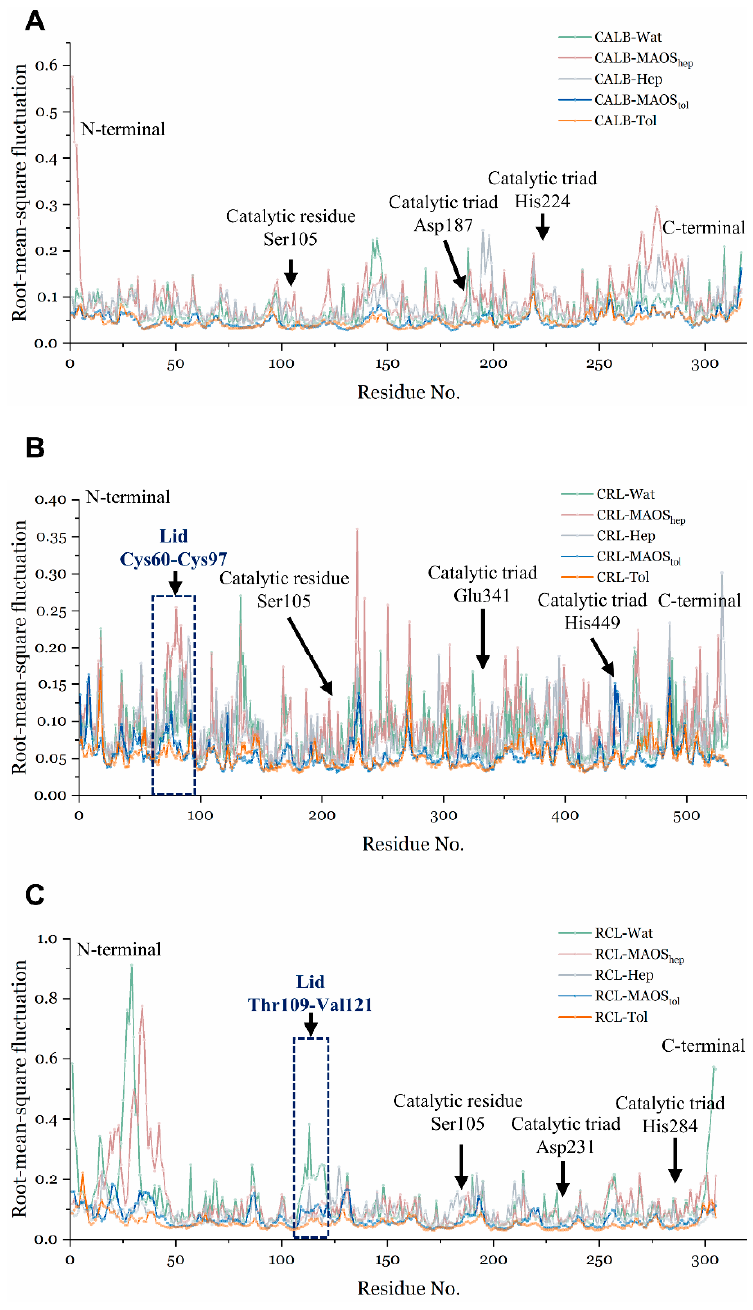
Figure 2. RMSF of CALB ( A ), CRL ( B ) and RCL ( C ) in the in water (green), MAOS hep (pink), MAOS tol (blue), n-heptane (ice-blue), toluene (orange). The lid region, catalytic residue and catalytic triad are presented in the corresponding regions.